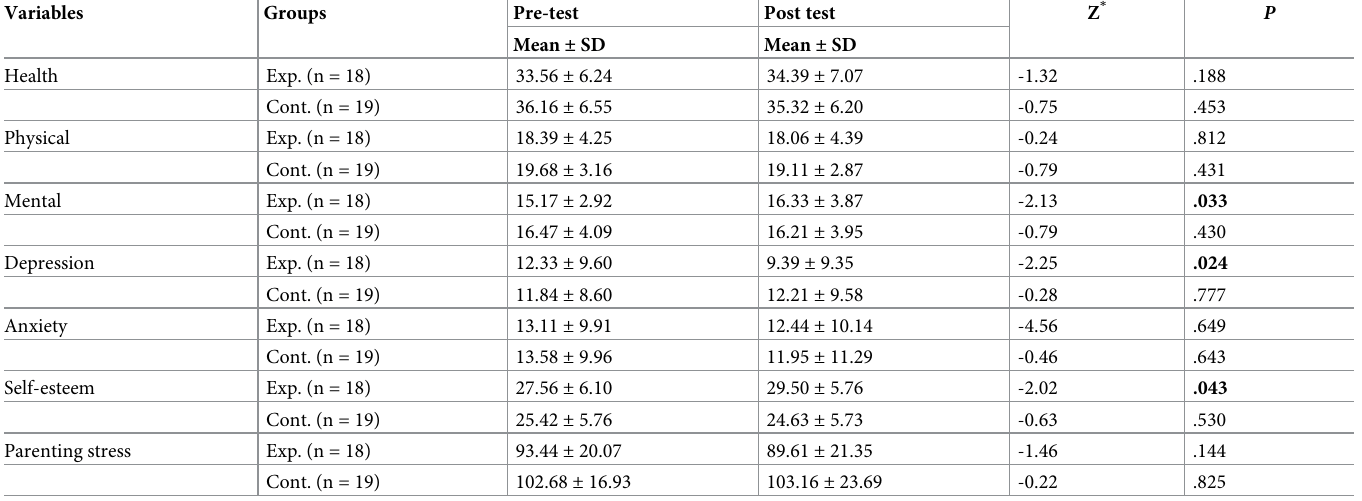
Table 3. Difference in outcome variables between the two groups (N =